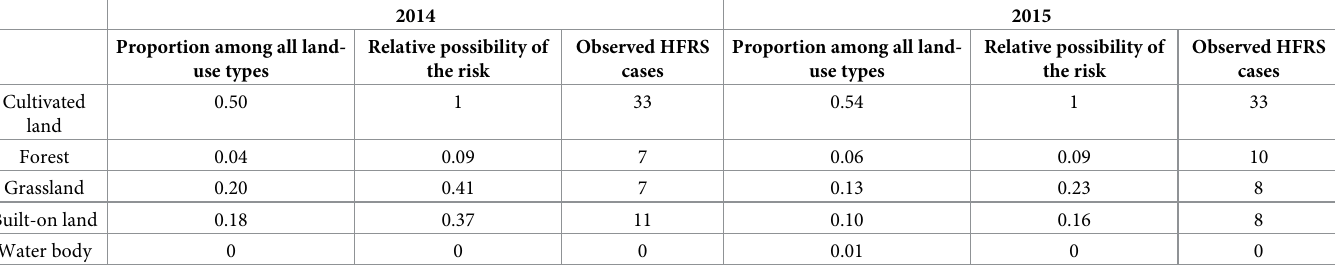
occurrence proportions among the different land-use types in the off-diagonal area (Table 4) performed less well: r = 0.76 (P < 0.05, n = 10) and R 2 = 0.58, and should therefore be regarded as having only slight credibility. Such cross-validation proved the reliability of the formula (2) again. Table 2. Predicted proportions and relative possibility of HFRS incidence risk and the number of observed HFRS cases among the different land types in 2014 and 2015. 2014 2015